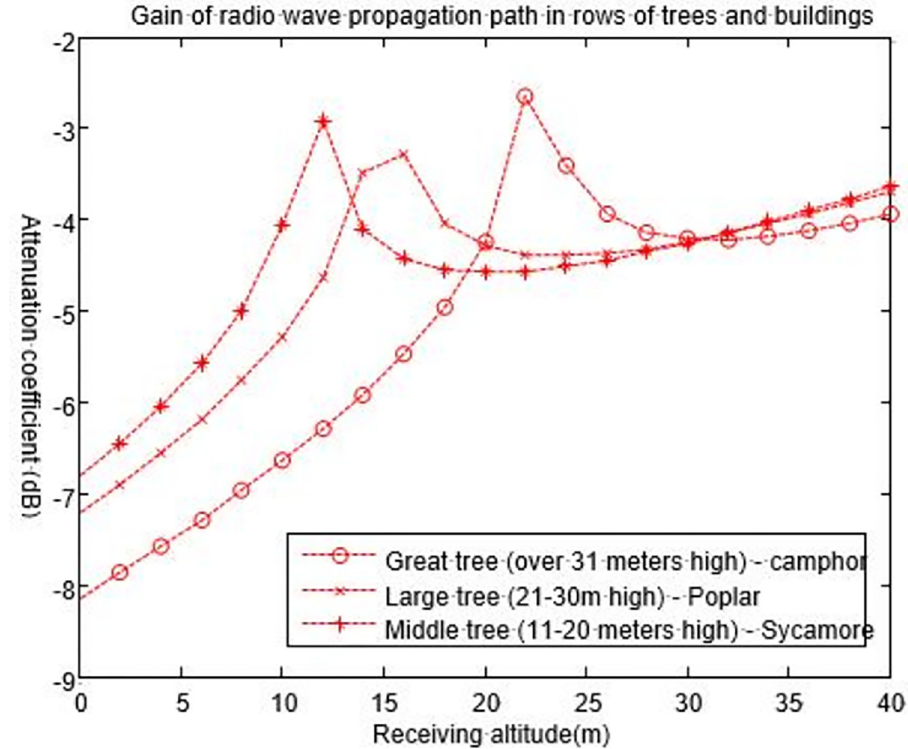
Fig 13. Path gain using the triangle tree